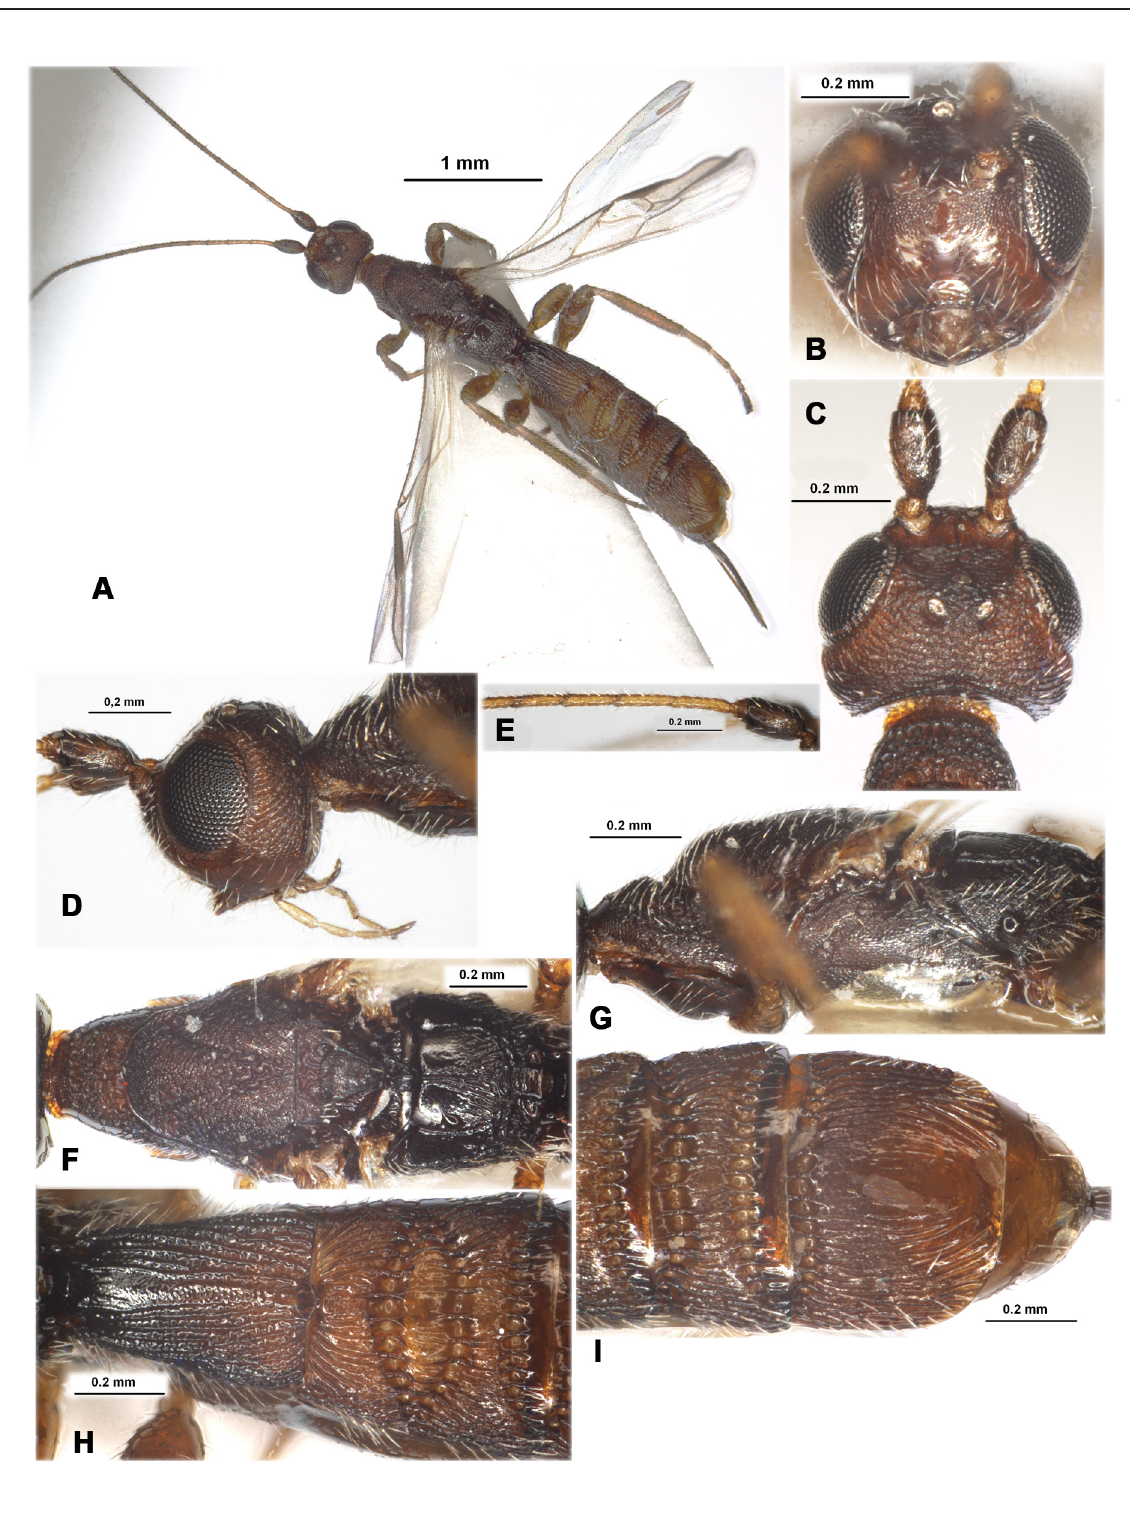
Fig. 47. Rhaconotus ( Rh. ) arabicus Belokobylskij, 2001, ♀ (RMNH). A . Habitus, dorsal view. B . Head, front view. C . Head, dorsal view. D . Head, lateral view. E . Basal segments of antenna. F . Mesosoma, dorsal view. G . Mesosoma, lateral view. H . First to third metasomal tergites, dorsal view. I . Fourth and fifth metasomal tergites, dorsal